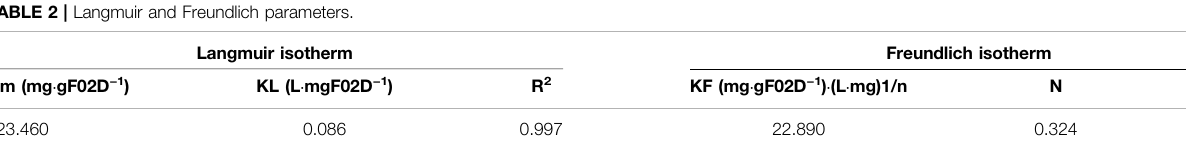
TABLE 2 | Langmuir and Freundlich parameters. Langmuir isotherm Freundlich